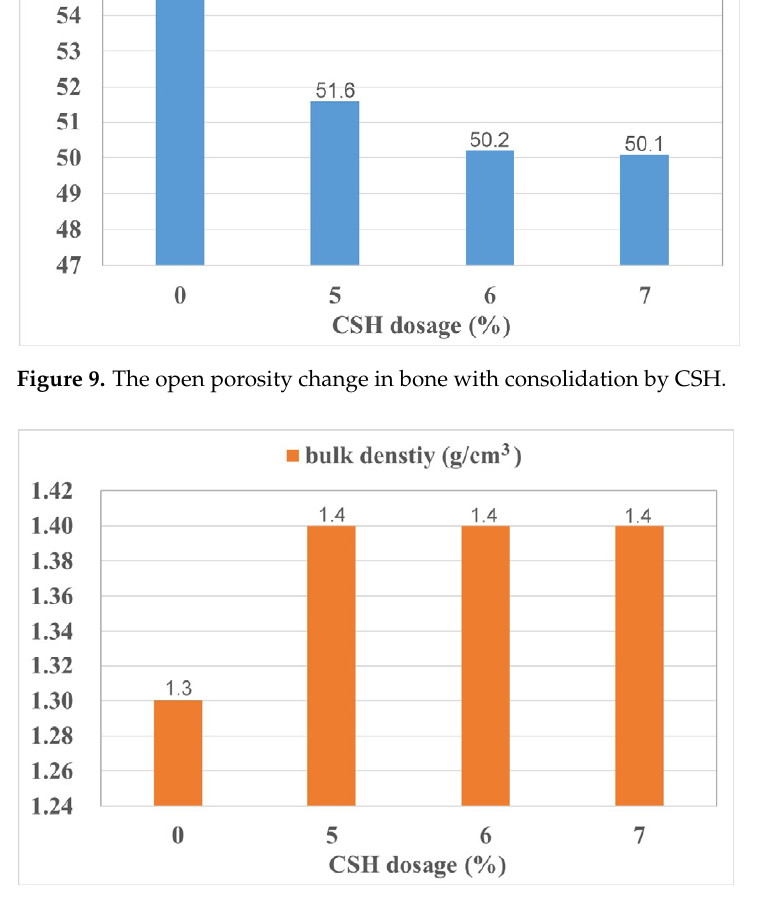
Figure 10. The bulk density change in the bone, samples after consolidation by CSH.